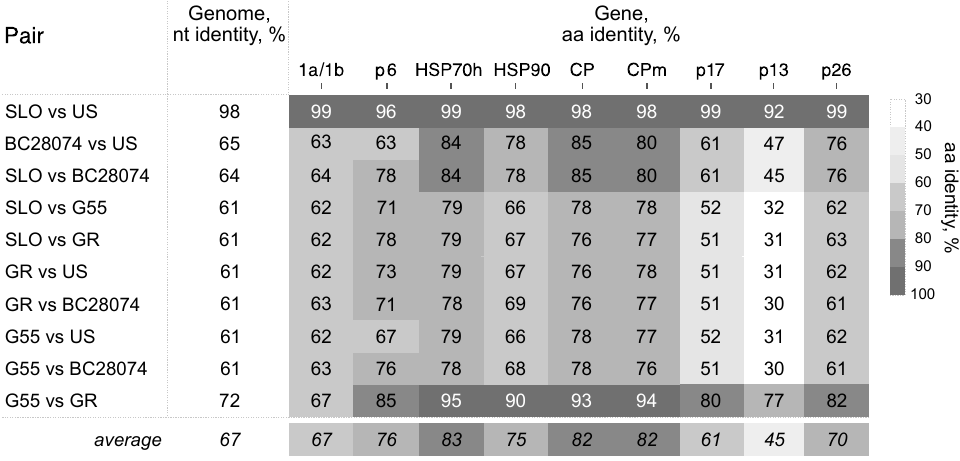
Figure 3. Pairwise nucleotide and predicted amino acid (aa) protein identities among BcLRaV-1 isolates. Noticeably, neither the predicted 1b, HSP70h, nor the CP proteins showed more than 25% diversity, the species demarcation identity criteria for closteroviruses [15]. No two isolates, except SLO and US, shared no more than 90% amino acid identities across genes. The isolates infecting the red currant were more than 80% identical, with the exception of